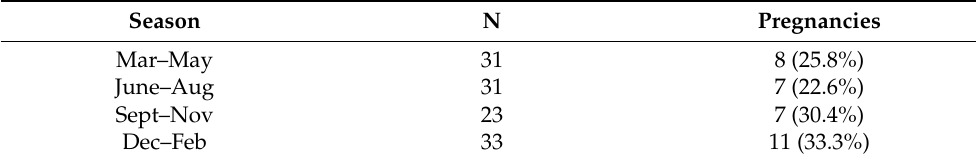
Figure 1. The effect of season on the number of follicles and COCs recovered during LOPU as well as in vitro embryo production rates. ( A ): LOPU results by season. ( B ): Embryo development rates by season. ( C ): The mean number of embryos produced per donor per LOPU by season. Table 2. Pregnancy rates after embryo transfer according to season.